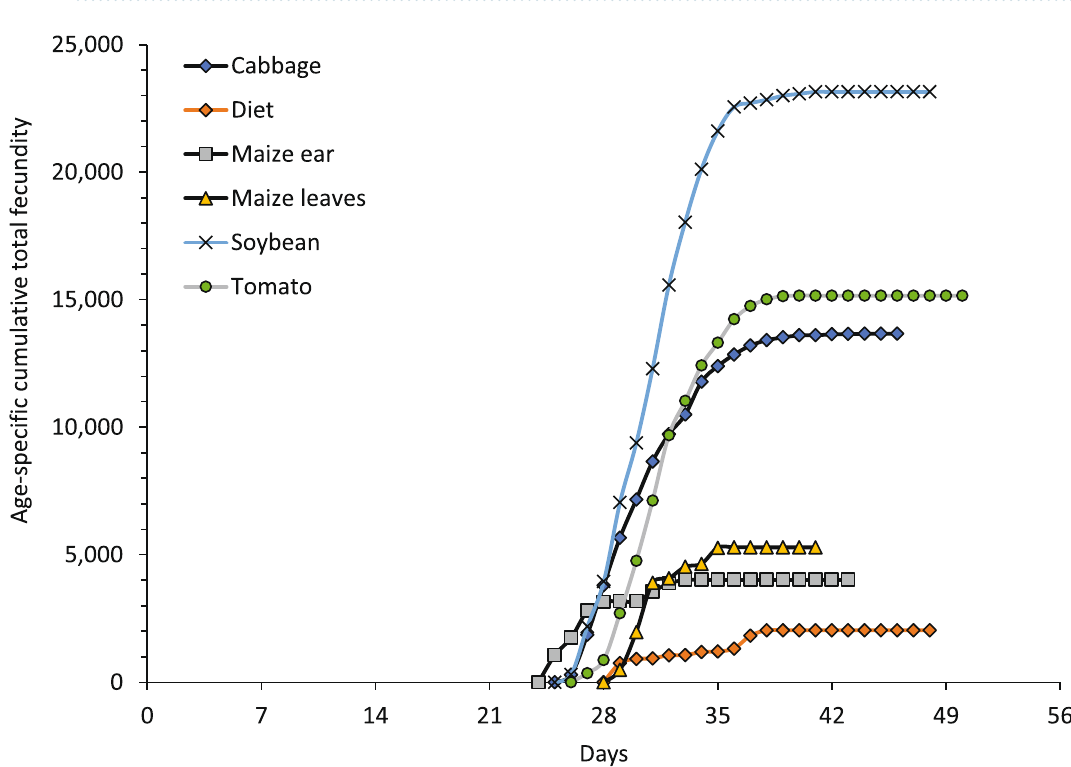
Figure 5. Cumulative fecundity of the fall Armyworm, Spodoptera frugiperda fed on cabbage, maize ear, maize leaves, artificial diet, soybean, and